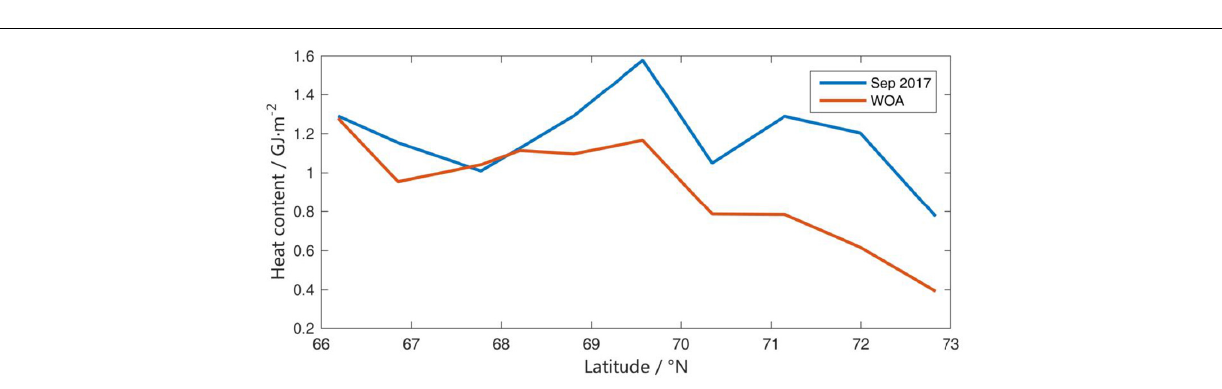
FIGURE 3 | Temperature (A) and salinity (B) sections in September 2017, and the temperature (C) and salinity (D) anomalies. The locations of the sections are shown in Figure 1 . Inverted triangles at the top of each figure indicate the locations of stations.